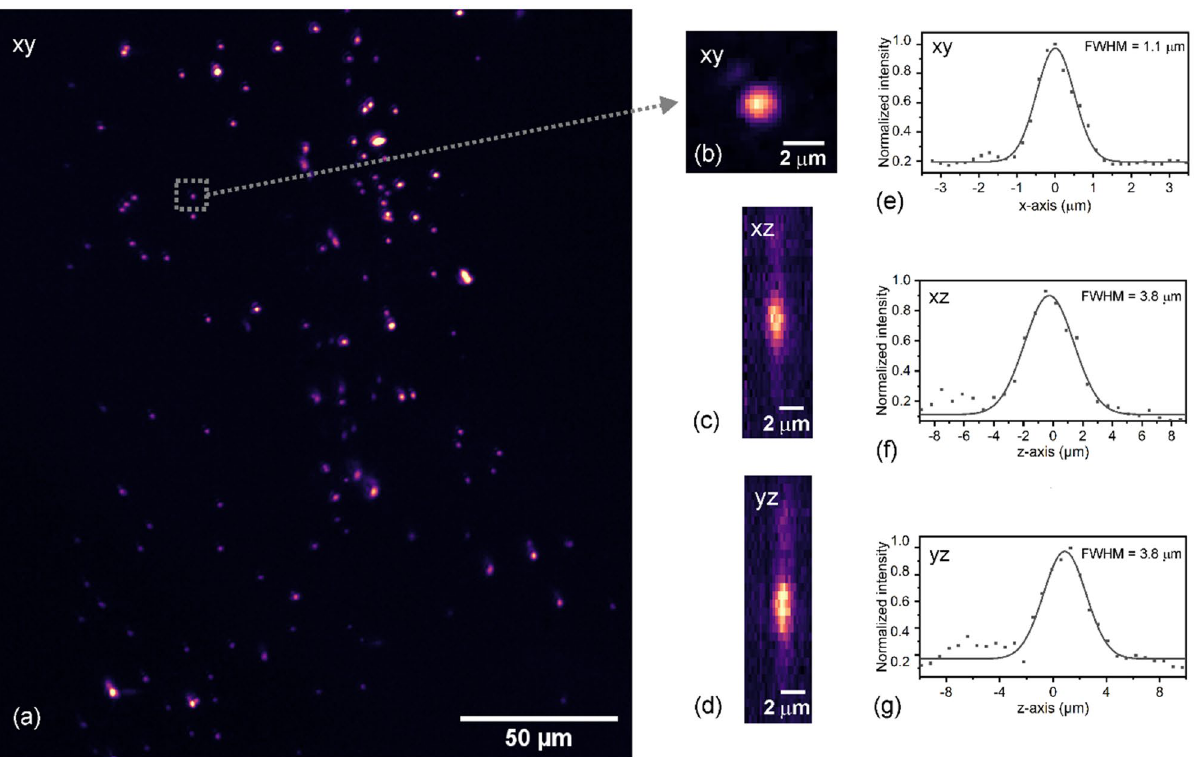
Figure 6. Sub-resolution nanobeads to evaluate the PSFs of the system. ( a ) An exemplar xy maximum intensity projection of 500 nm fluorescence beads at 50 μm imaging depth; ( b ) xy, ( c ) xz and ( d ) yz images of an exemplar single bead highlighted in ( a ); ( e )–( g ) measured cross-sections of the bead, including a Gaussian fit to show the 3D